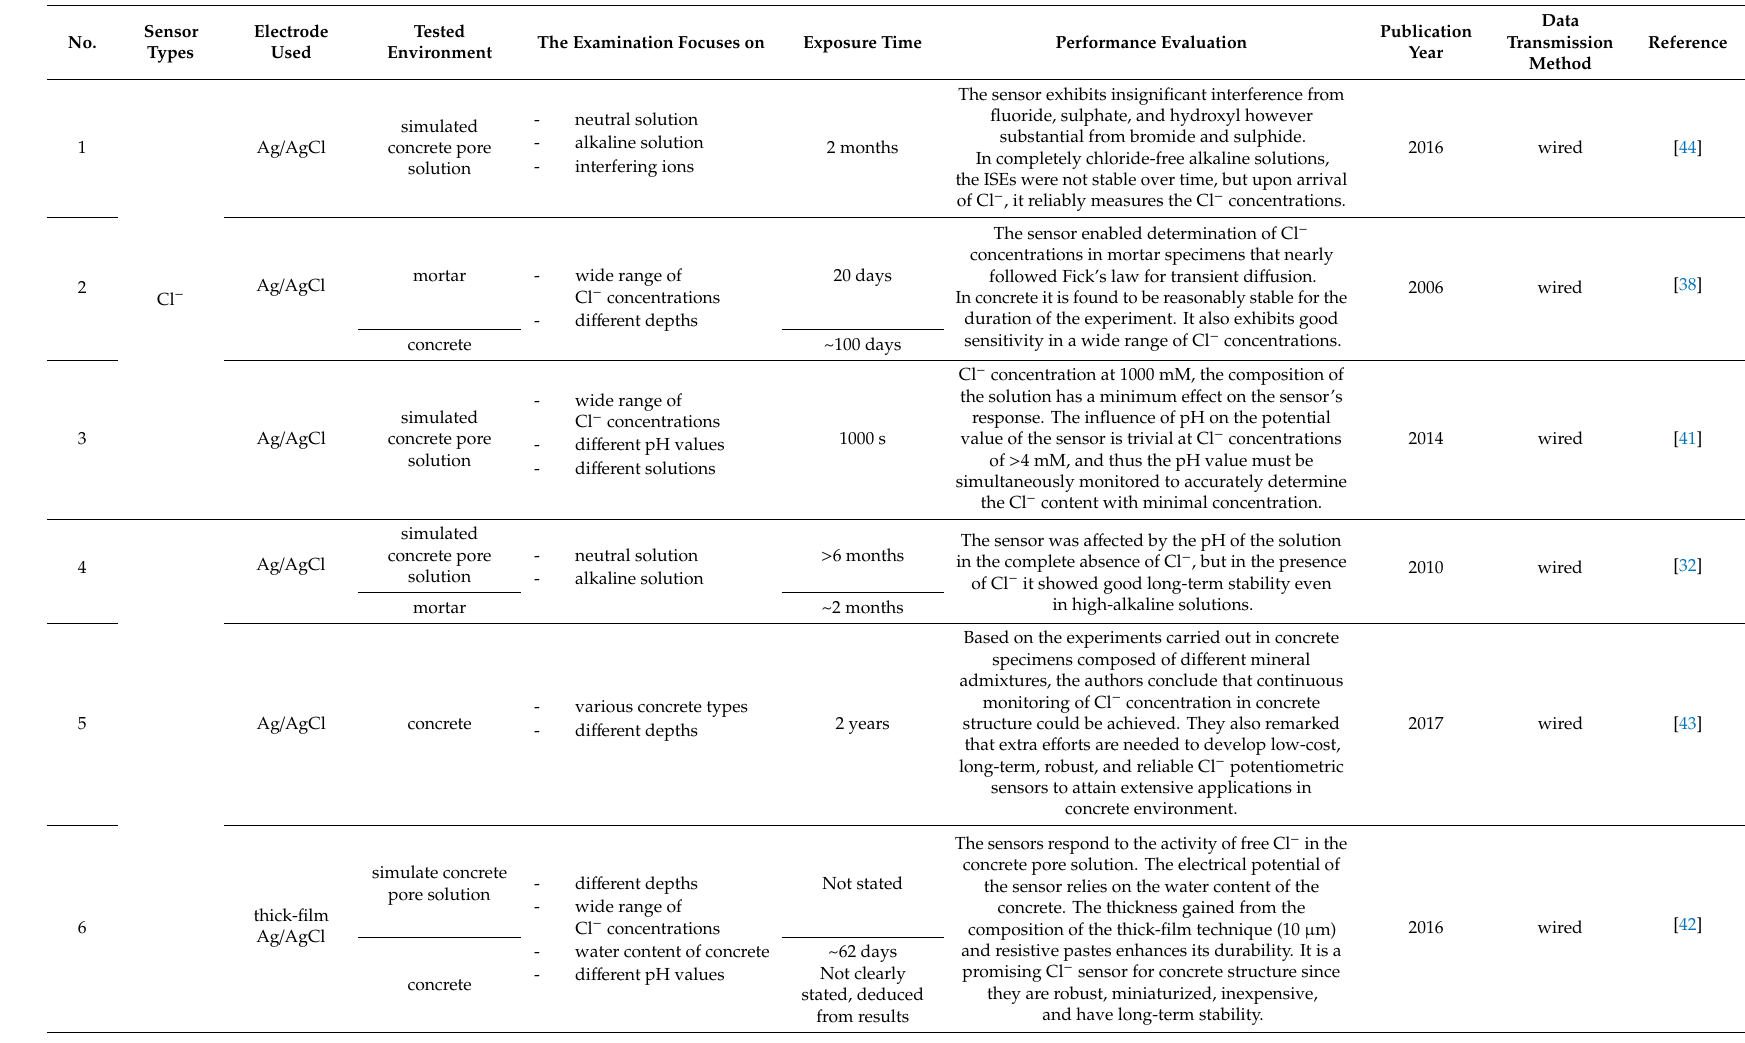
Table 3. State-of-the-art Cl − and pH potentiometric sensors details, test environment and their